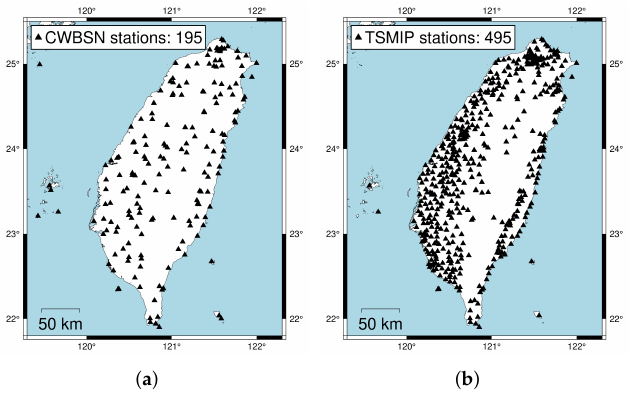
Figure 2. The figures show the station deployment of the seismological monitoring networks used in this work. ( a ) The station deployment of the Central Weather Bureau Seismic Network (CWBSN). ( b ) The station deployment of the Taiwan Strong Motion Instrumentation Program (TSMIP)